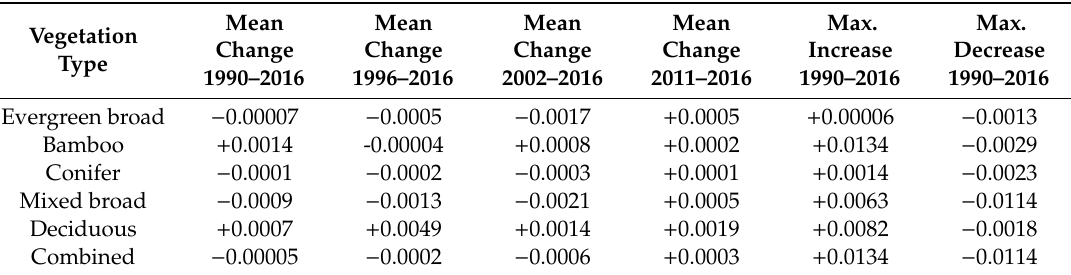
Table 3. Mean change in estimated boar per day between years, and maximum increase and maximum decrease between 1990 and